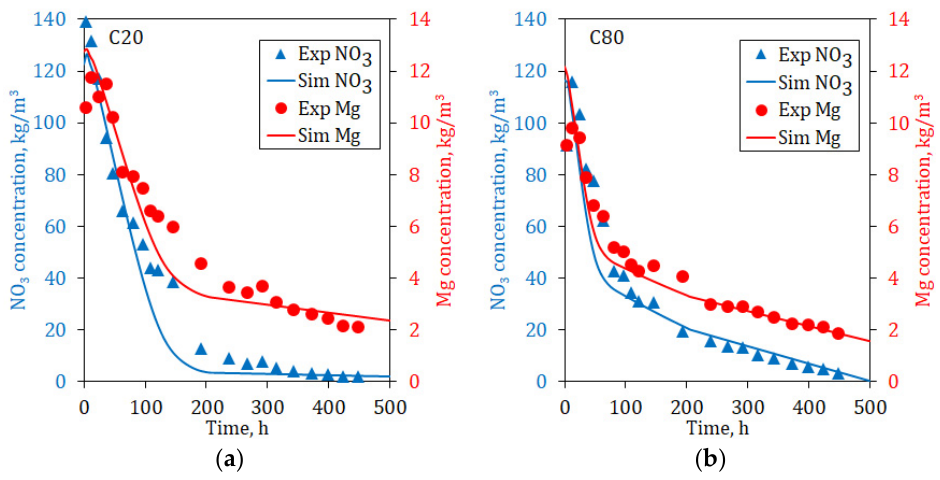
Figure 8. Comparison between simulated (lines) and experimental data (dots) for Nitrate (A-species) and Magnesium (B-species) for the columns: ( a ) C20 and ( b ) C80.